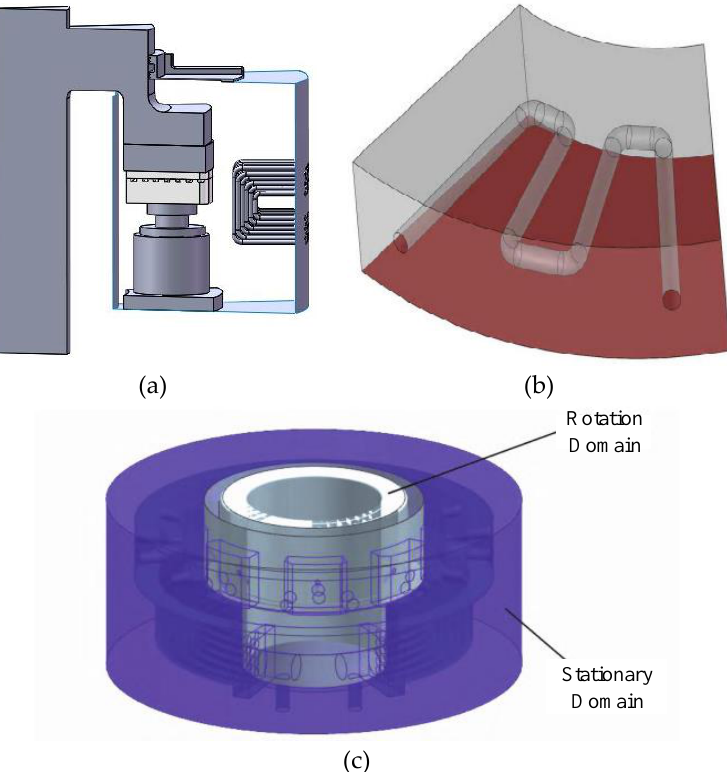
Figure 8. Structure of calculation model. ( a ) Diagram of 1/12 thrust bearing model [41]; ( b ) diagram of 1/6 thrust bearing pad model [115]; ( c ) integral lower guide bearing model.